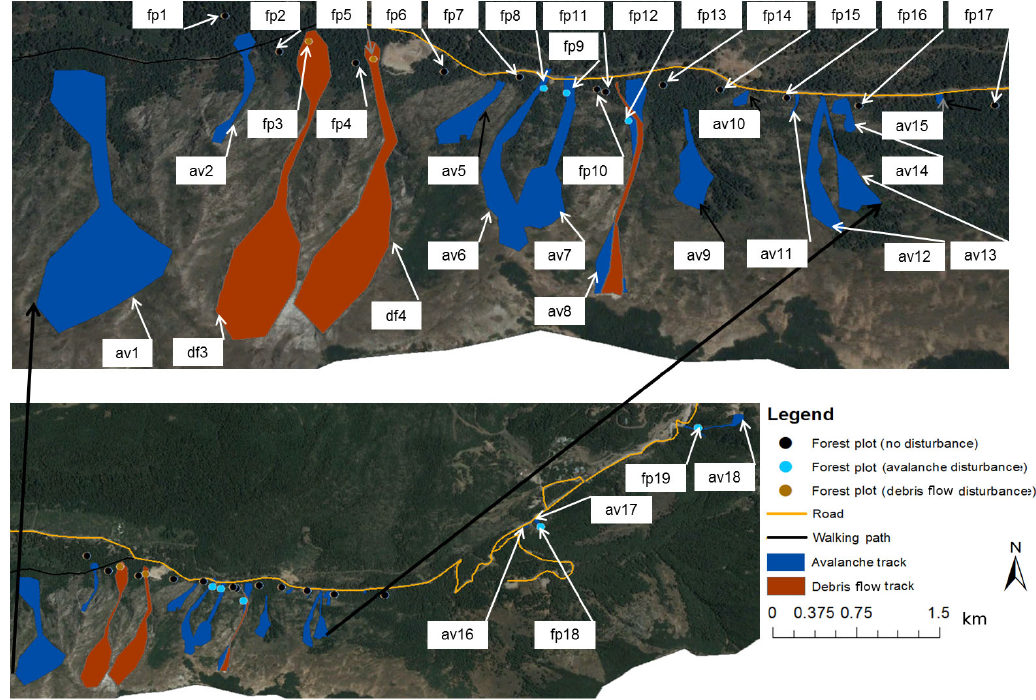
Figure 3. Snow avalanche tracks, debris flow tracks and forest plots (fp) at the study area. Tracks depicted in blue correspond to snow avalanches, whereas those in red correspond to both snow avalanches and debris flows. A total of 18 tracks were identified in the study area and 19 forest plots were